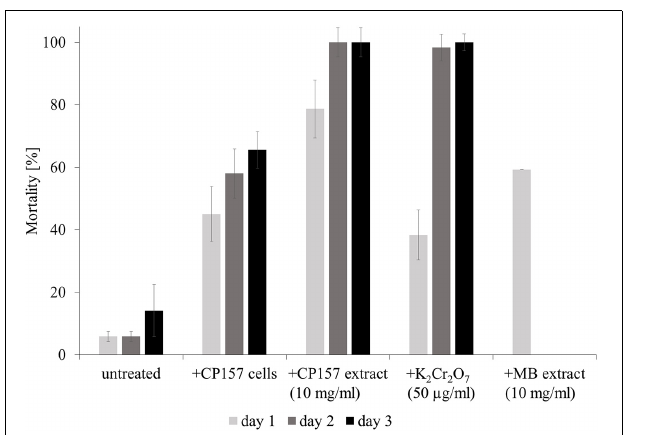
FIGURE 3 | Mortality of Artemia salina larvae when untreated, exposed to CP157 cells, CP157 culture extract or MB extract. For the latter two, the effects of the lowest tested dose (10 mg/ml) are shown exemplarily. K 2 Cr 2 O 7 served as a positive control for biotoxicity. Values are means ± standard deviation ( n = 3).